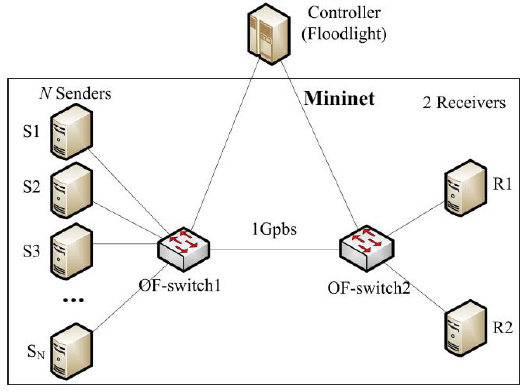
Figure 8. Experiment topology.